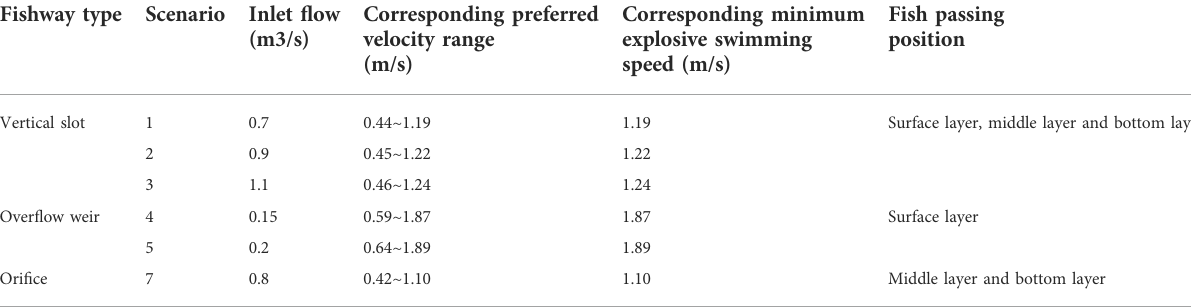
TABLE 8 Comparative analysis of the hydraulic characteristics of different types of fi shways. Fishway type Scenario Inlet fl